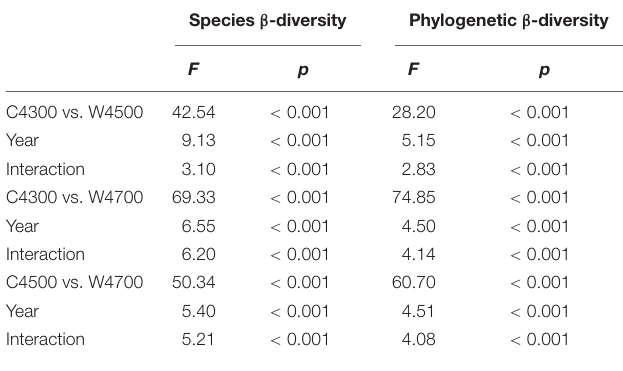
TABLE 2 | The two-way permutational multivariate analysis of variance (i.e., the “adonis2” of Vegan-package) for analyzing the differences of species β -diversity ( β Bray ) and phylogenetic β -diversity ( β MNTD) between C4300 vs. W4500, C4300 vs. W4700, or C4500 vs. W4700), and the effects of measuring year on the β Bray and β MNTD across the 9 years in